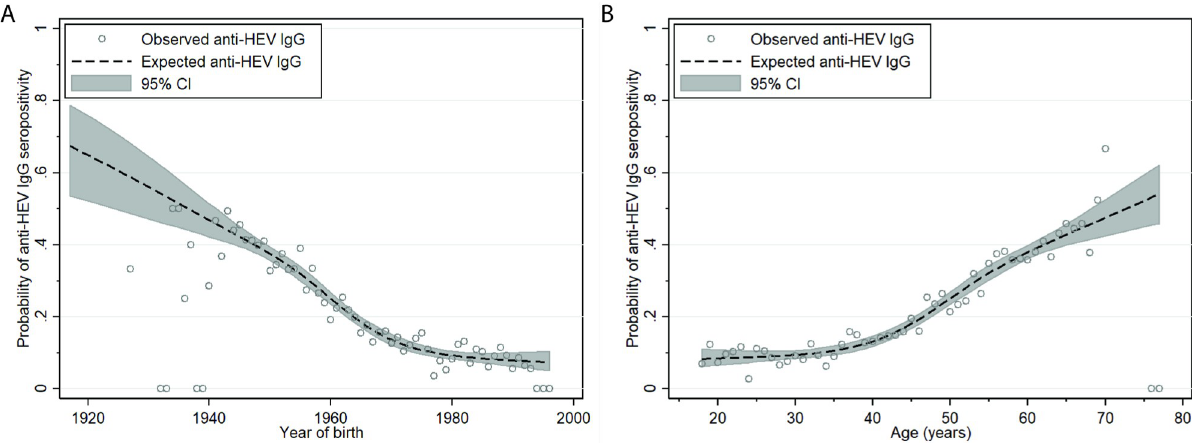
Fig 2. Estimated probability of IgG HEV seroprevalence by age (left, p < 0.001) and by year of birth (right, p < 0.001) among 7,065 participants of the total study population. Expected IgG HEV seroprevalence is derived from a 4-knot restricted cubic spline standard logistic regression model using default knot values (dashed line). The grey shading depicts the 95% confidence interval for expected IgG HEV seroprevalence. Dots represent the observed seroprevalence of IgG HEV per age-year and per birth-year.